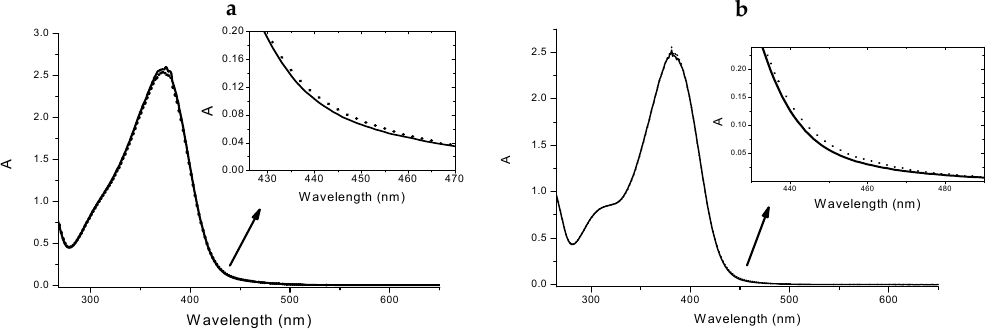
Figure 4. Absorption spectra of 4 4 × 10 − 5 M in absence (solid line) and in presence (dotted line) of 2.5 × 10 − 5 M Cu(II) ( a ). Inset: spectral detail of the changing upon the addiction of the metal. Absorption spectra of 5 4 × 10 − 5 M in absence (solid line) and in presence (dotted line) of 2.5 × 10 − 5 M Cu(II) ( b ). Inset: spectral detail.